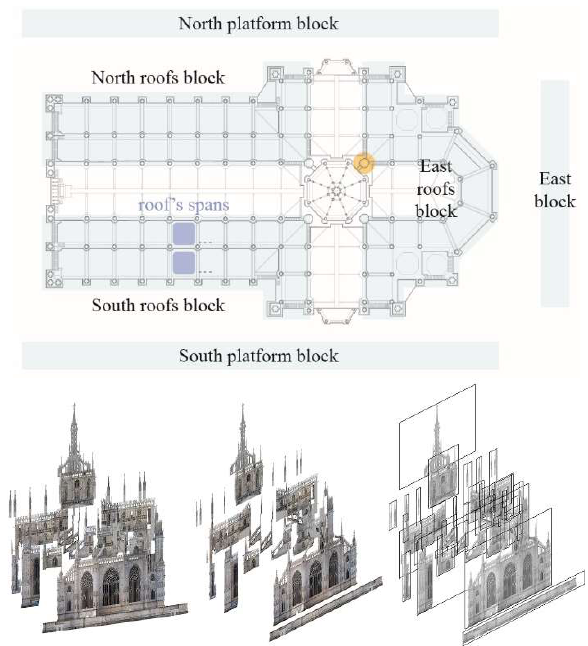
Figure 2. block division: alignment segmentation (light blue), dense matching segmentation (blue), Amadeo spire (yellow). Mosaicking of the orthoimages (bottom).